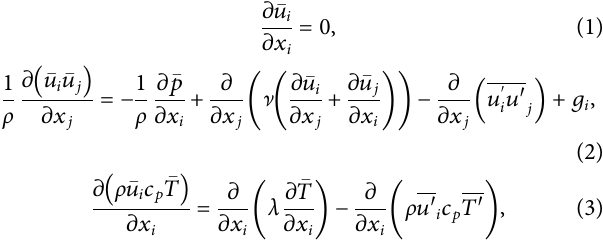
FIGURE 4 | (A) Schematic of preliminary core structures and size. (B) Schematic of 1/12 of the fuel layer.